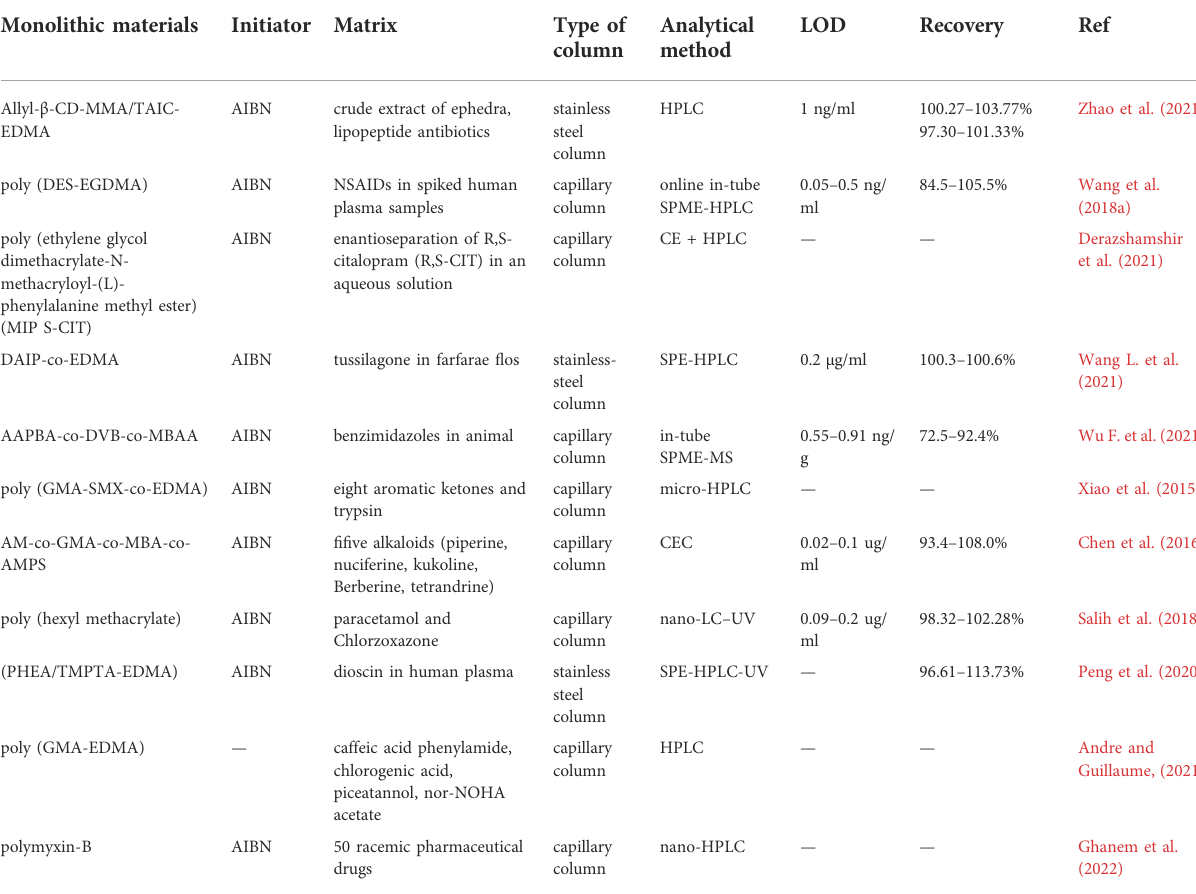
TABLE 3 Application of polymer monolithic columns in medicine. Monolithic materials